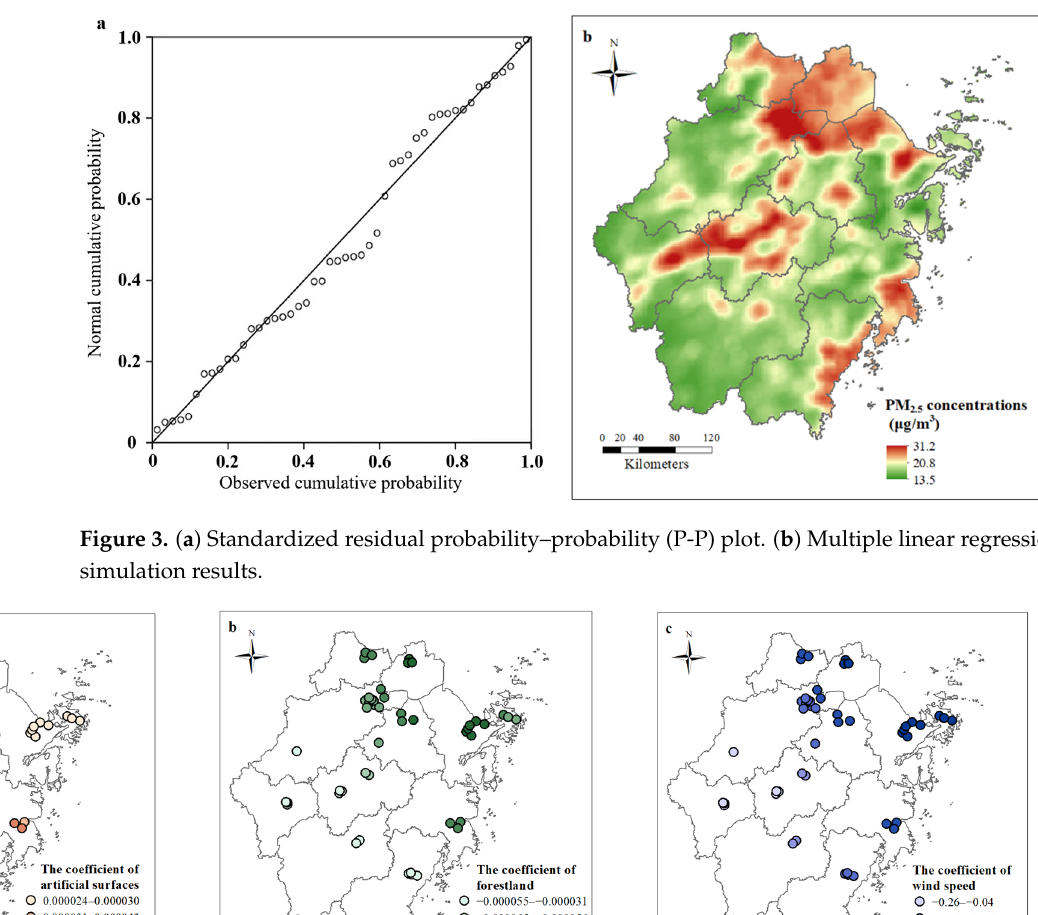
Figure 5. ( a ) Standardized residual P-P plot. ( b ) Simulation results of the GWR-based improved land use regression (LUR) model. The simulation results of the spatial distribution of the GWR-based improved LUR model are shown in Figure 5b, which are generally consistent with the results of the mul- tiple linear regression simulation. The PM 2.5 pollution concentration areas are roughly the same, mainly in the urbanized areas of northern Zhejiang, central Zhejiang, and south- eastern Zhejiang.